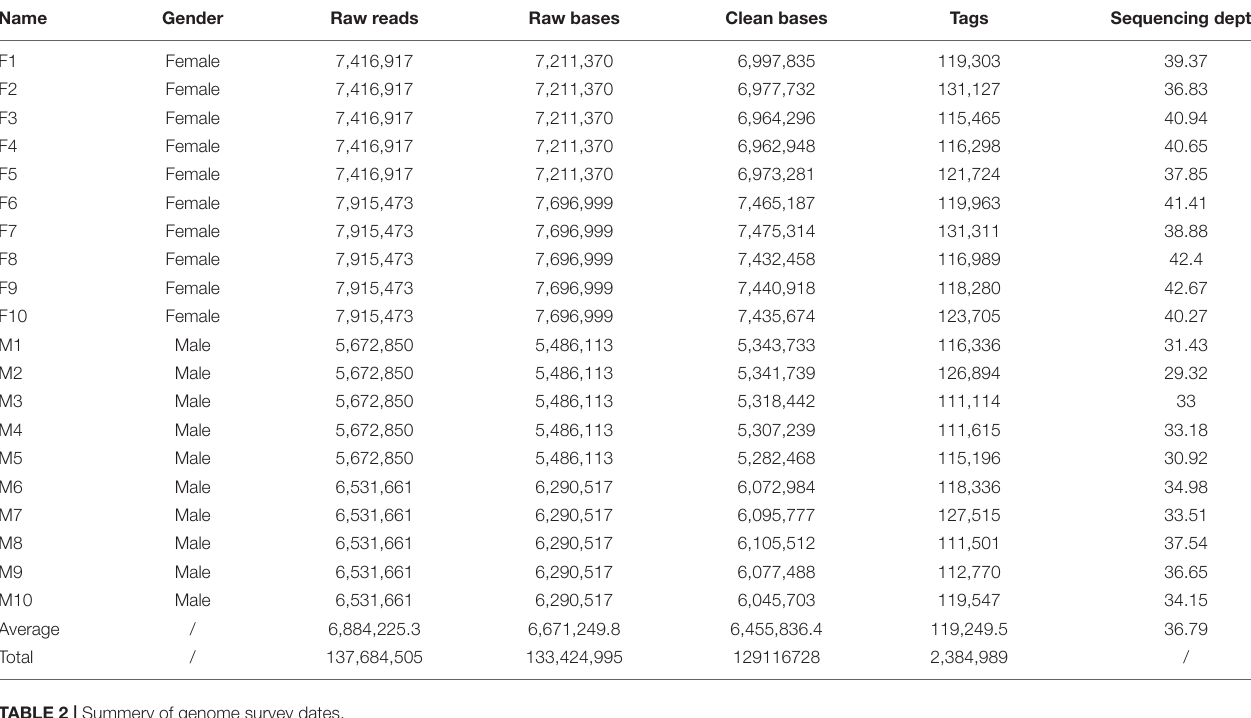
TABLE 1 | Summary of 2b-RAD data obtained from 20 M. nudus individuals.